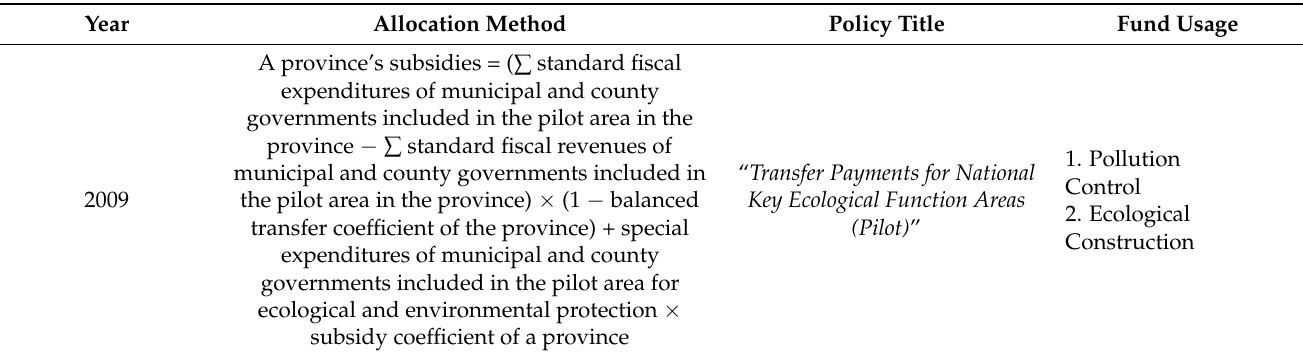
Table A1. The Evolutionary History of